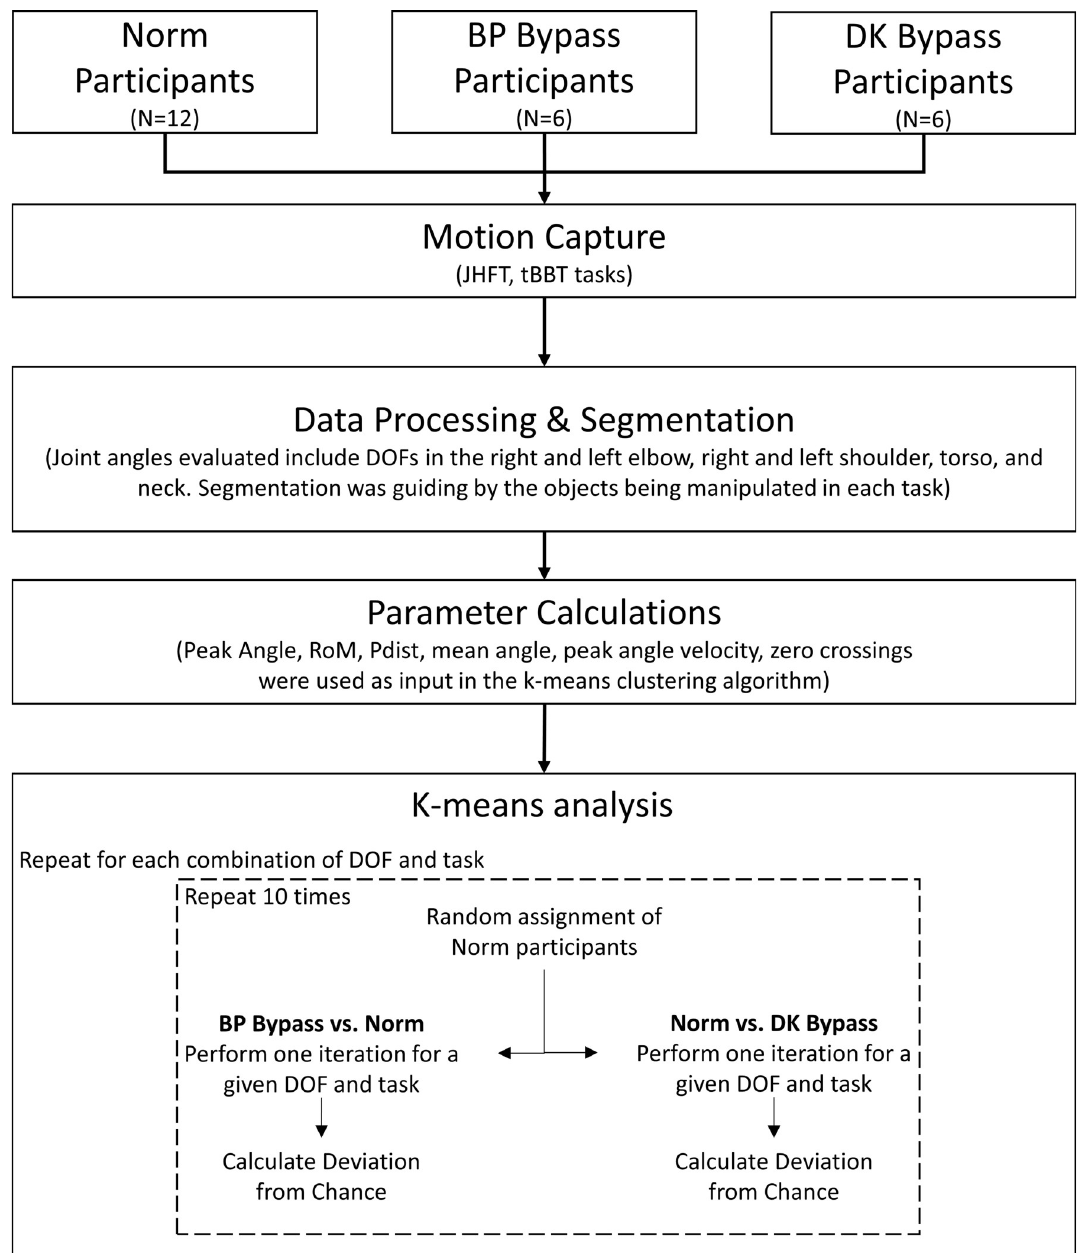
Fig 2. Flowchart of data collection and processing and the calculation of deviation from chance (DfC) metric.